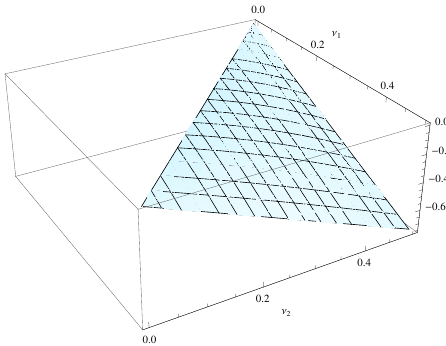
(cid:0) c (UV) as a function R R